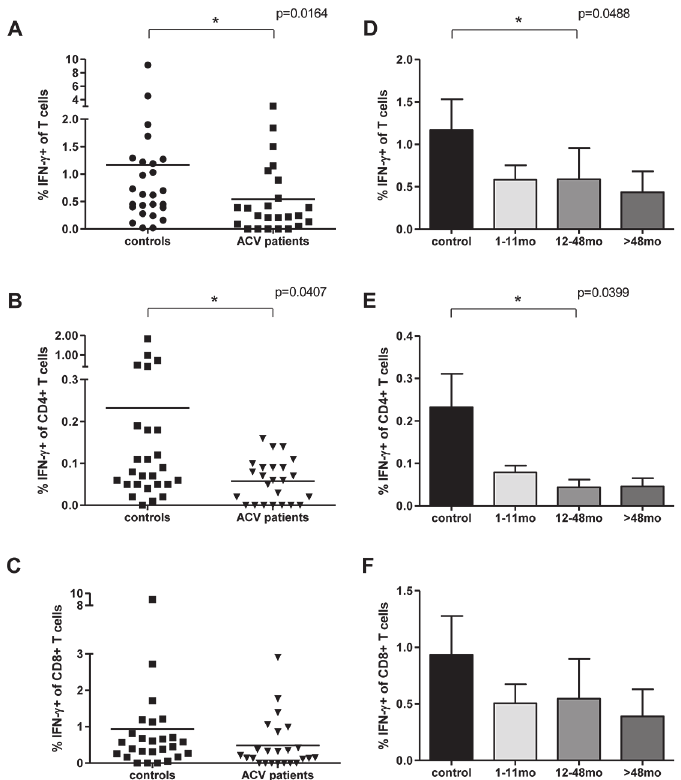
Fig 1. Frequency of pp65-specific T cells in patients taking acyclovir and in control subjects. IFN- γ production was determined in the total T cell population following stimulation with pp65 peptide pool using PBMC taken from ACV-treated subjects and control subjects (A). The individual responses of CD4+ T cells (B) and CD8+ T cells (C) are also shown. In (D-F) the proportion of pp65-specific T cells is represented accordingly in samples from donors who had been taking acyclovir for periods of 1 – 11 months, 12 – 48 months or over 4 years (n = 9, 8, 7 respectively). Means (A-C) or means with SEM (D-F) are